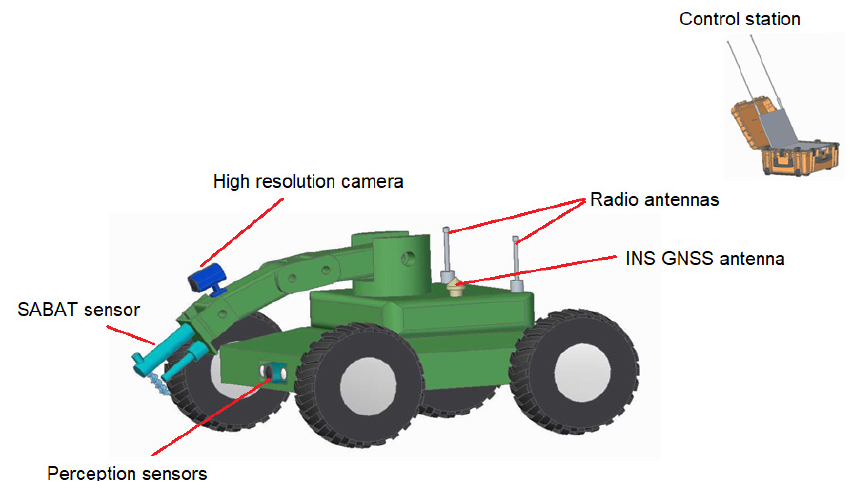
Figure 2. Schematic view of the SABAT sensor integrated with a ground vehicle simulated in this work. The sensor (light blue) is mounted on a manipulator arm with a camera (dark blue).